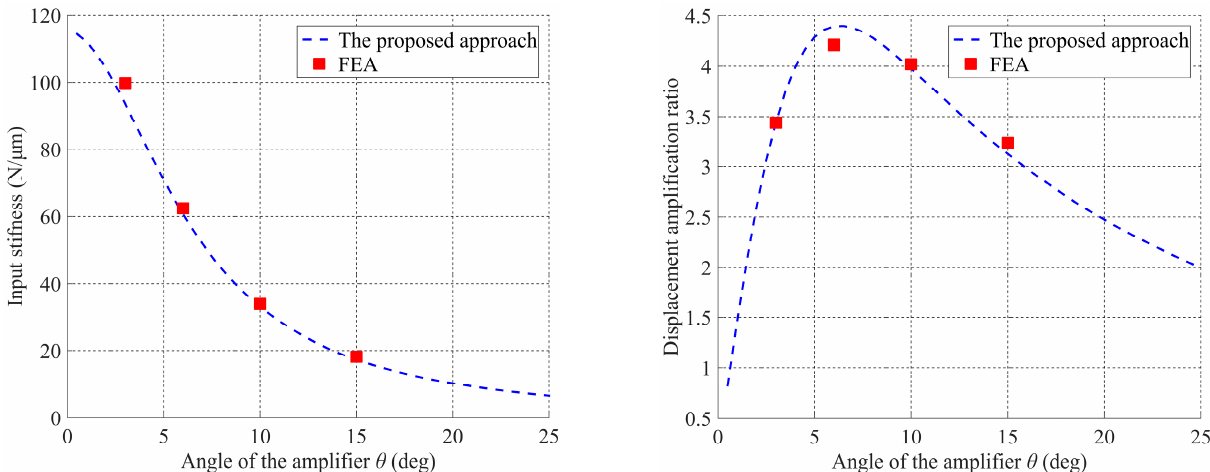
Figure 12. Simulation results of static performances. Table 1. Geometric and material parameters of the platform. Table 2. Comparison results of static